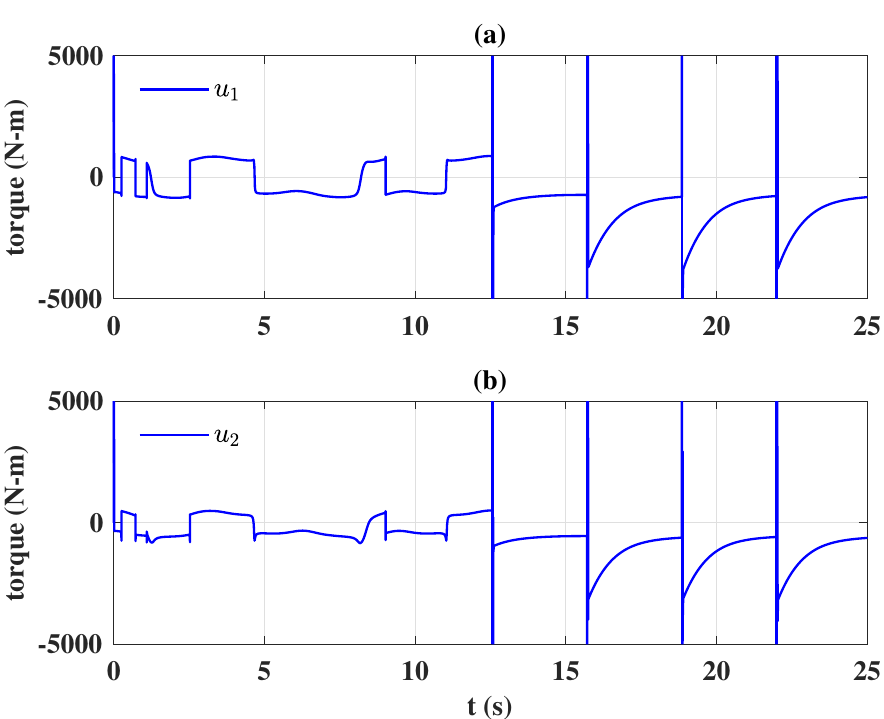
Figure 9. Time history of the control signals ( a ) u 1 and ( b ) u 2 with the extended references